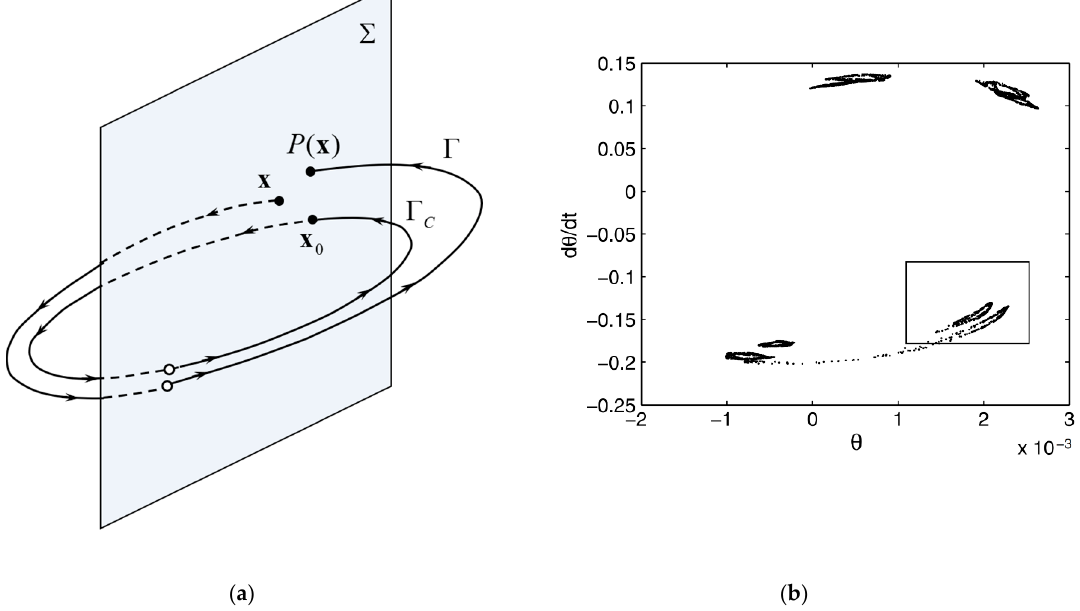
Figure 2. Illustration of a Poincaré map on ( a ) state space and ( b ) the Poincaré section. ( a ) is based on Figure 1 in Section 3.4 of Perko’s book, and ( b ) is based on Figure 20 ( a ) in Dimitriadis’ paper. ( b ) shows the normal method for a Poincaré map to be applied on the analysis of nonlinear behaviors in an aeroelastic system.